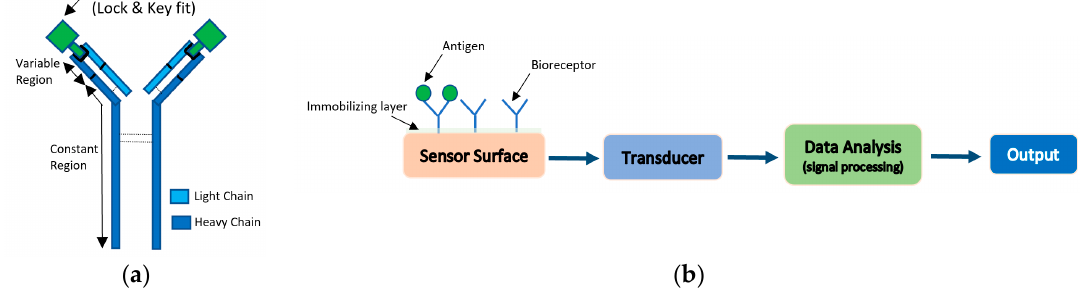
Figure 8. ( a ) Antigen and antigen-specific antibody “Lock and Key” sensing. ( b ) Functional block of antibody-based biosensors.